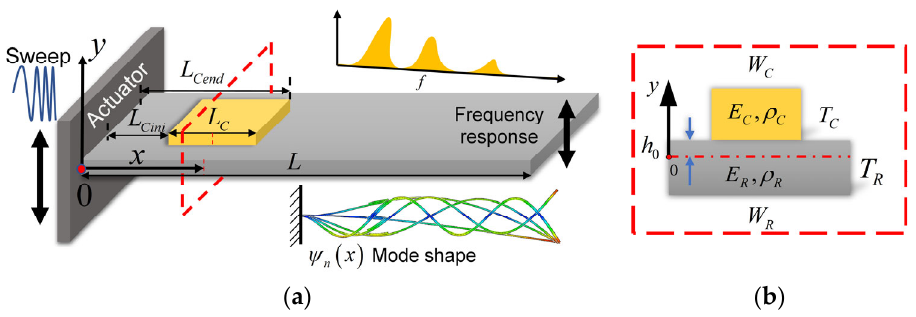
Figure 1. ( a ) The schematic diagram of the cantilever resonator with an adsorbate. ( b ) The cross- section of the adsorbate and the resonator.